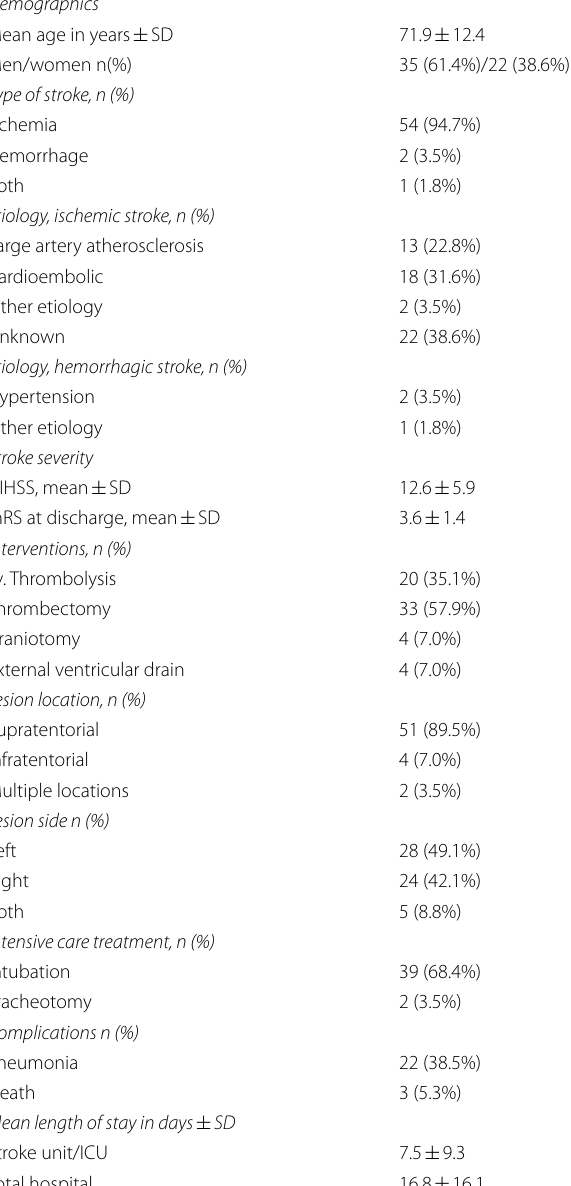
Table 1 clinical data of the patient cohort Table 2 Results of the sensory testing and severity and characterization of